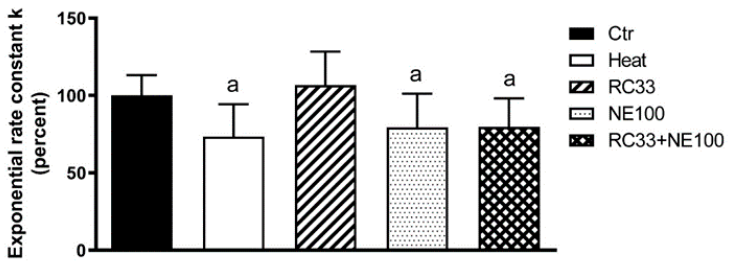
Figure 3. Effect of the NE100 and ( R/S )-RC33 co-administration on the water permeability of HeLa cells in heat-stress condition. Comparison between untreated cells (Controls, Ctr), cells treated at 42 °C for 3 h (heat-stressed, Heat), heat-stressed cells pre-treated separately with NE100 and ( R/S )- RC33 at 20 µM and heat-stressed cells pre-treated simultaneously with NE100 and ( R/S )-RC33. Bars represent the osmotic water permeability of HeLa cells expressed as percent of the exponential rate constant k. Values are means ± SD of 4–15 single shots (time course curves) for each of 4–6 different experiments. a, p < 0.05 vs. Ctr, ( R/S )-RC33 (Repeated measures ANOVA, followed by Newman- Keuls’s Q test).